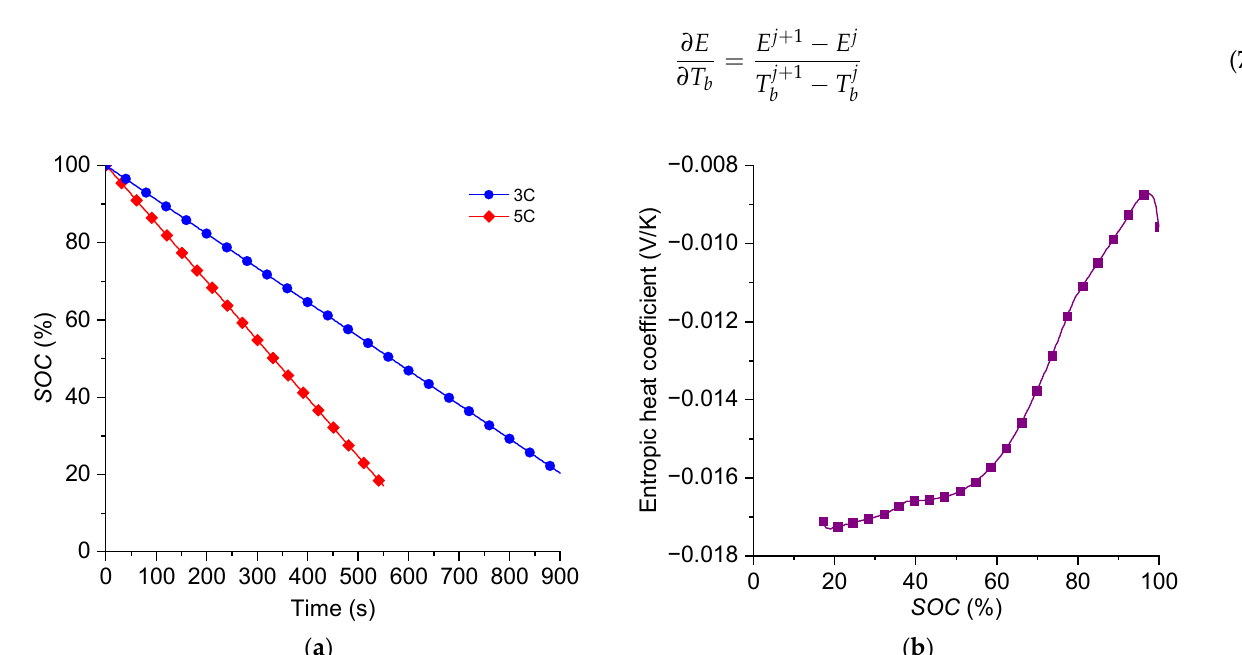
Figure 3. ( a ) SOC over time at different discharge rates. ( b ) Entropic heat coefficient as a function of SOC .